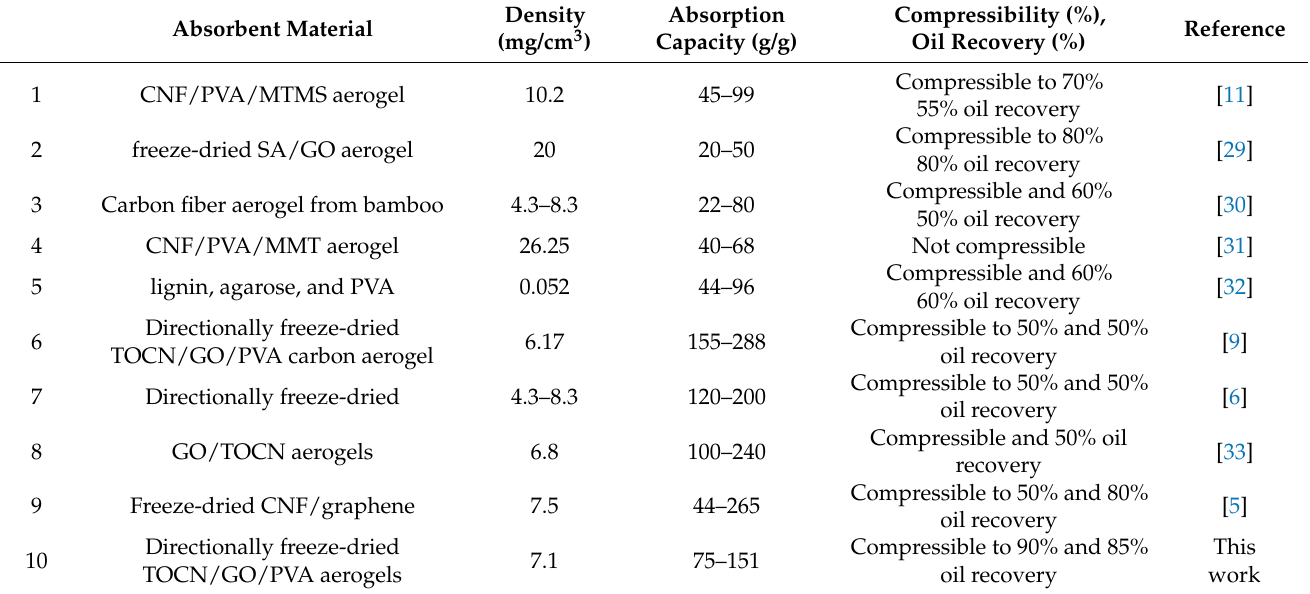
Table 2. Performance comparison of b-MGTPA with 3D absorbent materials reported in the